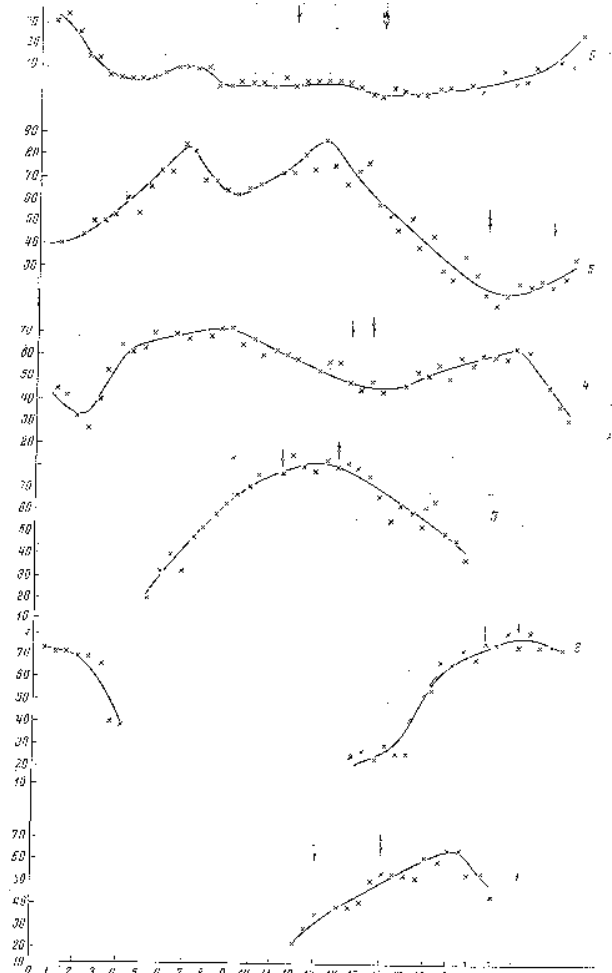
Figure 8. Diurnal variations of auroras appearance in zenith (Uni- versal Time). 1 – Verkhoyansk; 2 – Murmansk; 3 – Wrangel Island; 4 – Arctic I (North Pole 6); 5 – Piramida (Spitzbergen); 6 – Arctic II (North Pole 7). Figures along the axis of ordinates signify the frequency of appearance of auroras at zenith (in percent). The ar- row depicts local midnight, double arrow depicts local geomagnetic midnight ( Feldstein, 1960).